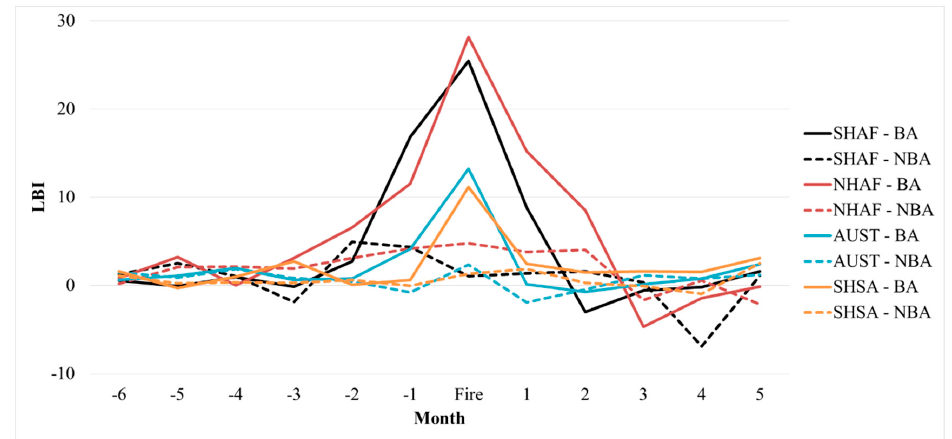
Figure 7. Monthly variation (2008) of the LTDR BA Index for an example of the burned area (BA) and unburned area (NBA) pixels. Southern Hemisphere South America (SHSA), Europe (EURO), Northern Hemisphere Africa (NHAF), Southern Hemisphere Africa (SHAF), and Australia and New Zealand (AUST).